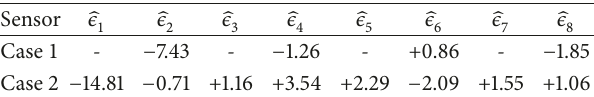
Table 14: Damage evaluation in case of 4 and 8 sensors on the continuous shear-deflecting structure, by using SVD-based algorithm.